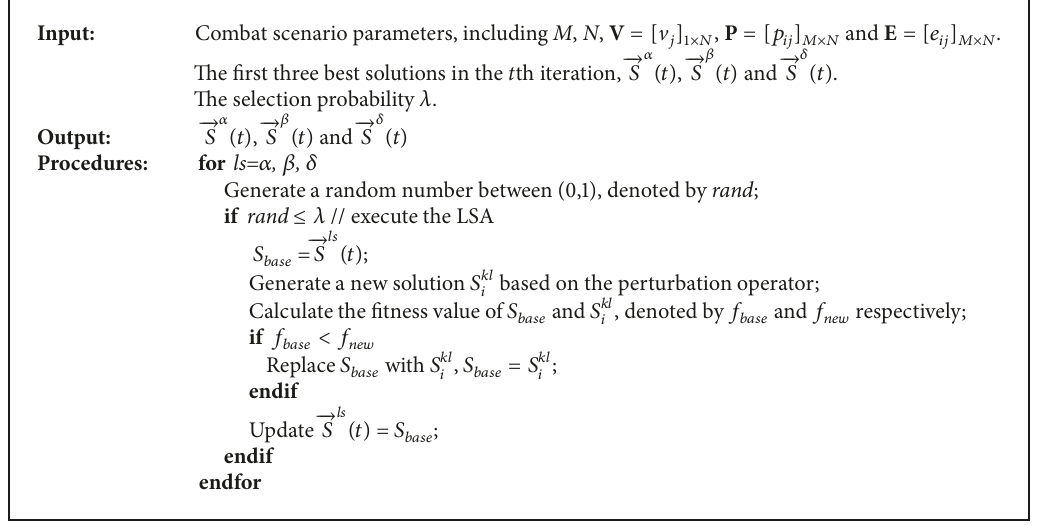
Algorithm 3: Pseudo-code of the local search